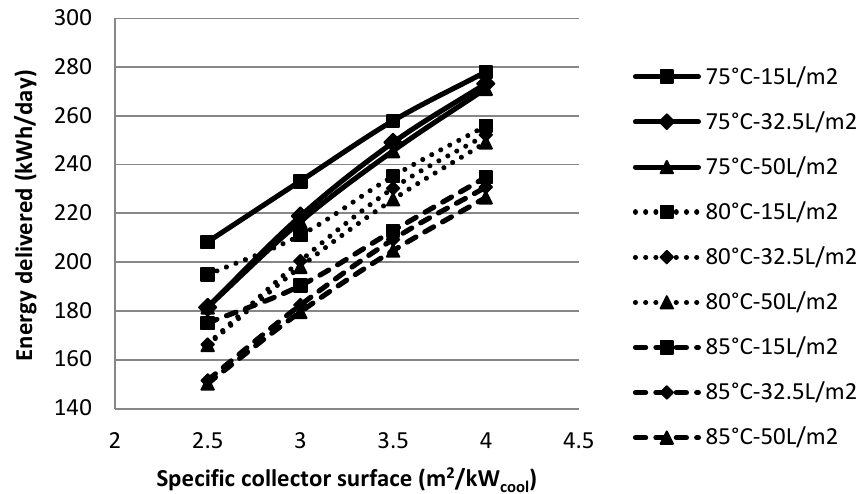
Figure 5. Energy delivered per day to the absorption chiller as a function of the specific collector